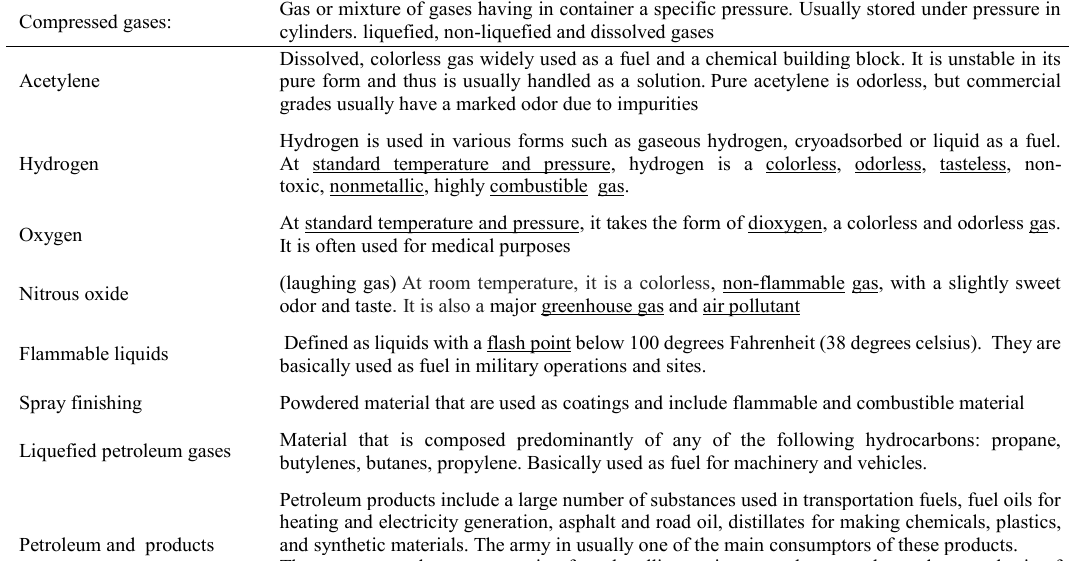
Table 1: Hazardous materials in the military